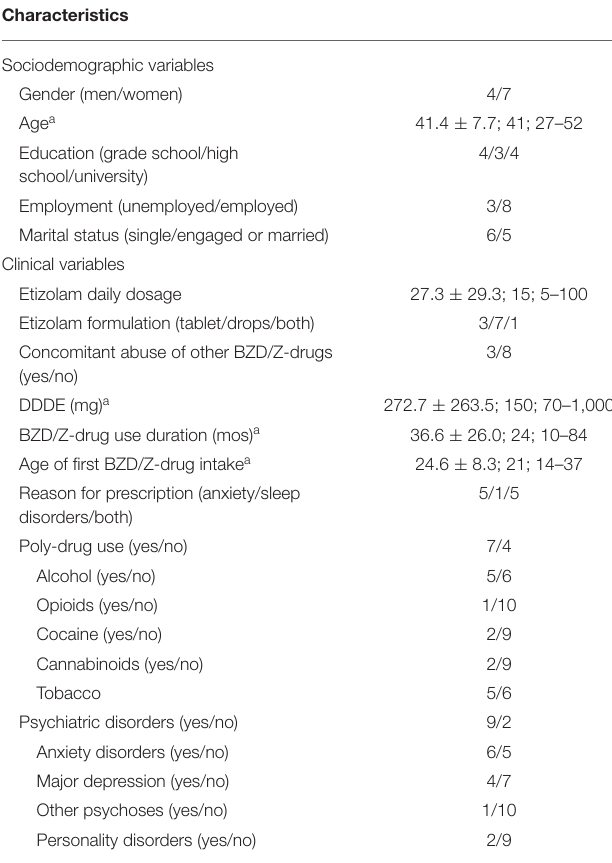
TABLE 1 | Sociodemographic and clinical characteristics of the